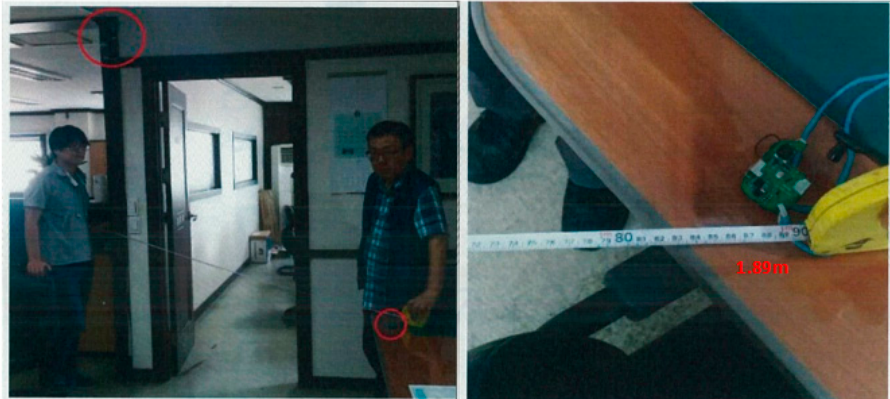
Figure 21. Location A and R2, and real distance between A and R2.